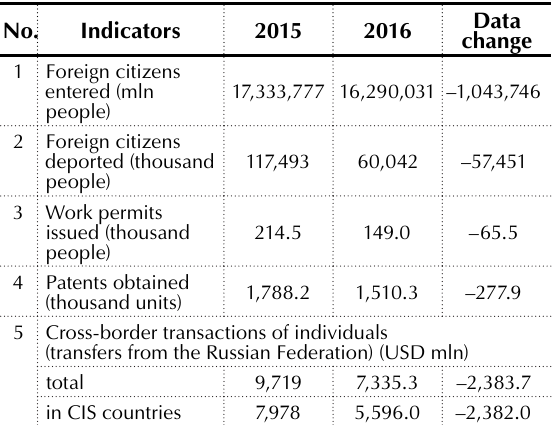
Table 2. Data on the migration situation in Russia and transfers of migrants in 2015 and 2016